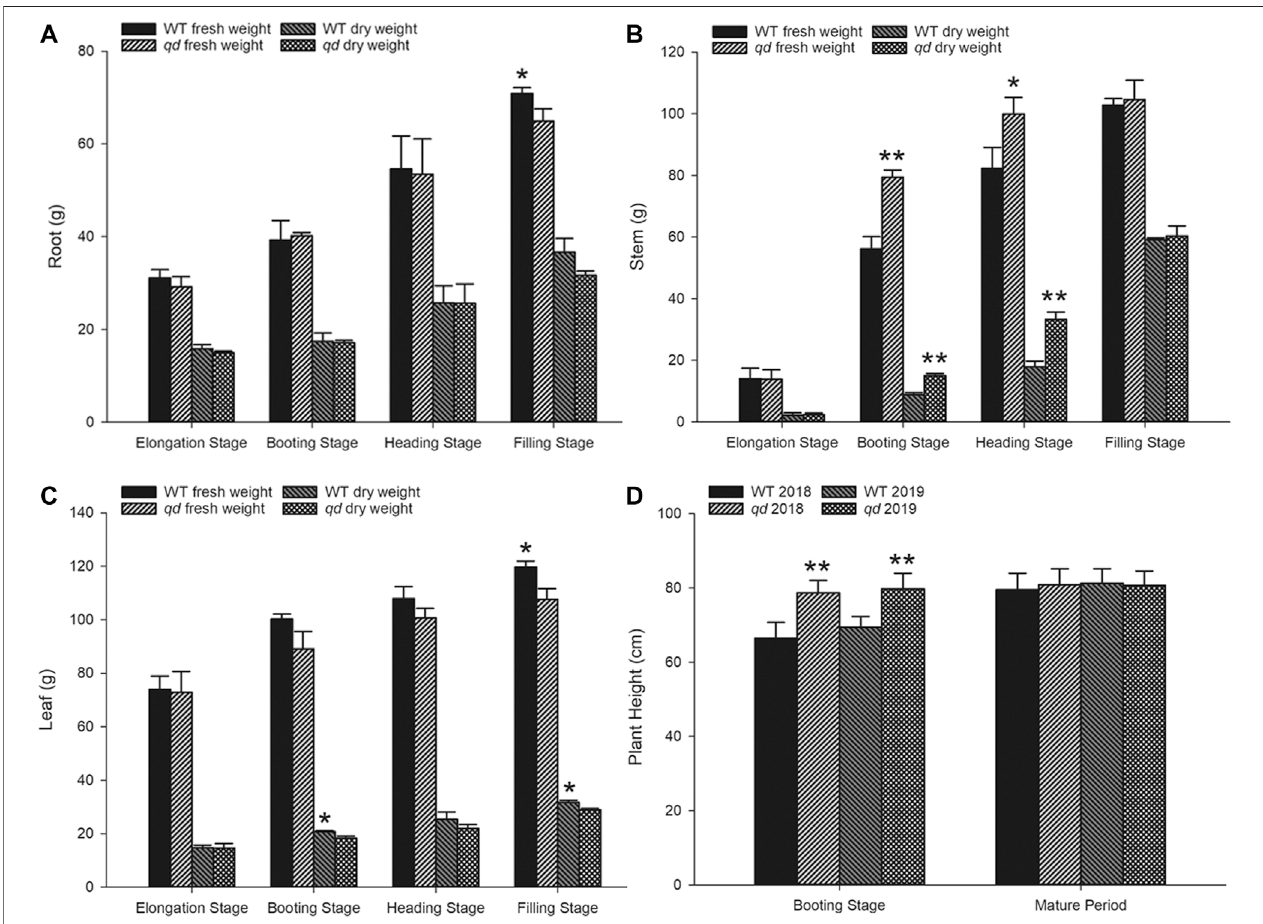
FIGURE2| PhenotypicdataofWTand qd plantsatvariousstages. (A) Rootweightcomparisonbetween qd andtheWT; (B) Stemweightcomparisonbetween qd and the WT; (C) Leaf weight comparison between qd and the WT; (D) Plant height comparison between qd and the WT Note: “ ** ” indicates that the difference between qd and the WT is signi fi cant at the 0.01 level; “ * ” indicates that the difference between qd and the WT is signi fi cant at the 0.05